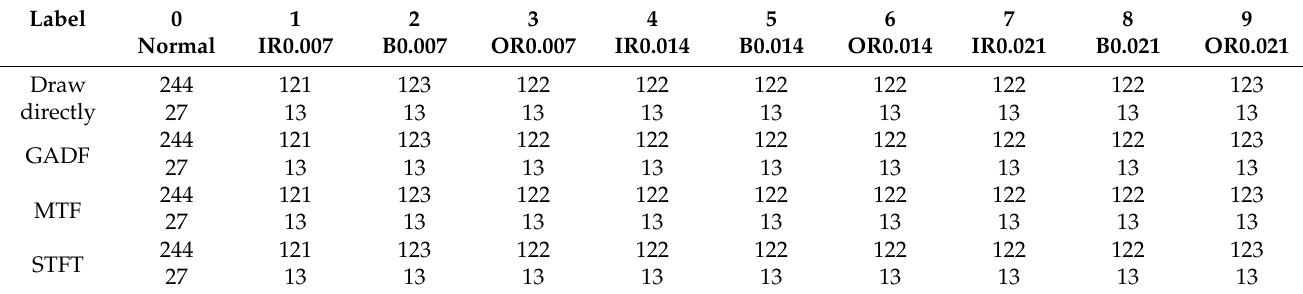
signal and contains the characteristics of the time series [42]. Table 2. CWRU single-channel